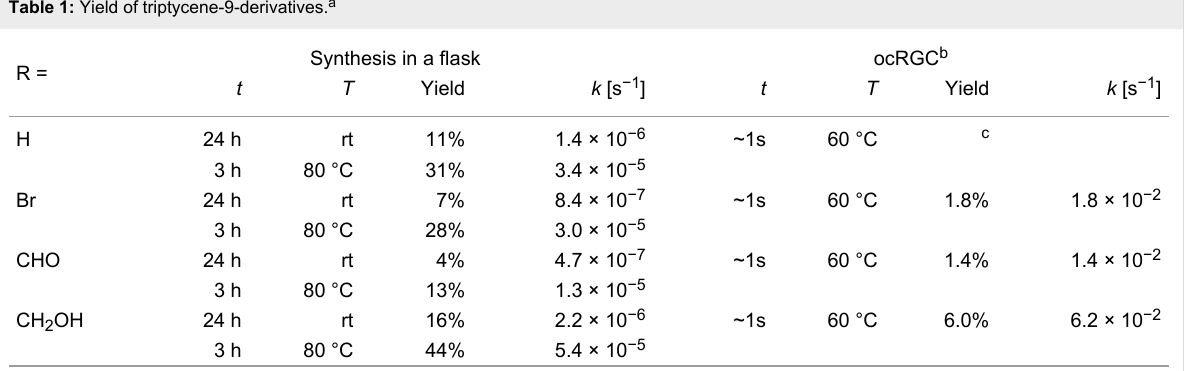
Table 1: Yield of triptycene-9-derivatives. a